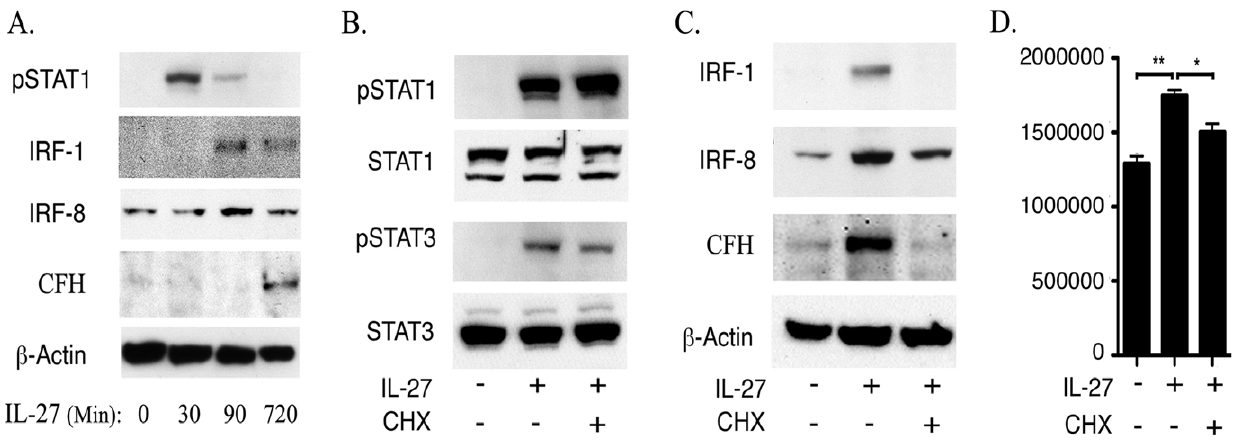
Figure 3. IL-27 induces expression of CFH through STAT1-mediated up-regulation of IRF-1 and IRF-8. (A–C) ARPE-19 cells were starved for 2 hours in serum free medium and cultures were then stimulated with IL-27 (10 ng/ml) for 30, 90 or 720 min. (B–D) In other cultures, cells were treated with CHX (35 ug/ml) for 30 min prior treatment with IL-27 for 30 min (B) or 24 h (C, D). Whole cell extracts were analyzed by Western blot assay and the antibodies used are indicated. (D) CFH mRNA transcripts were detected and quantified by qRT-PCR.